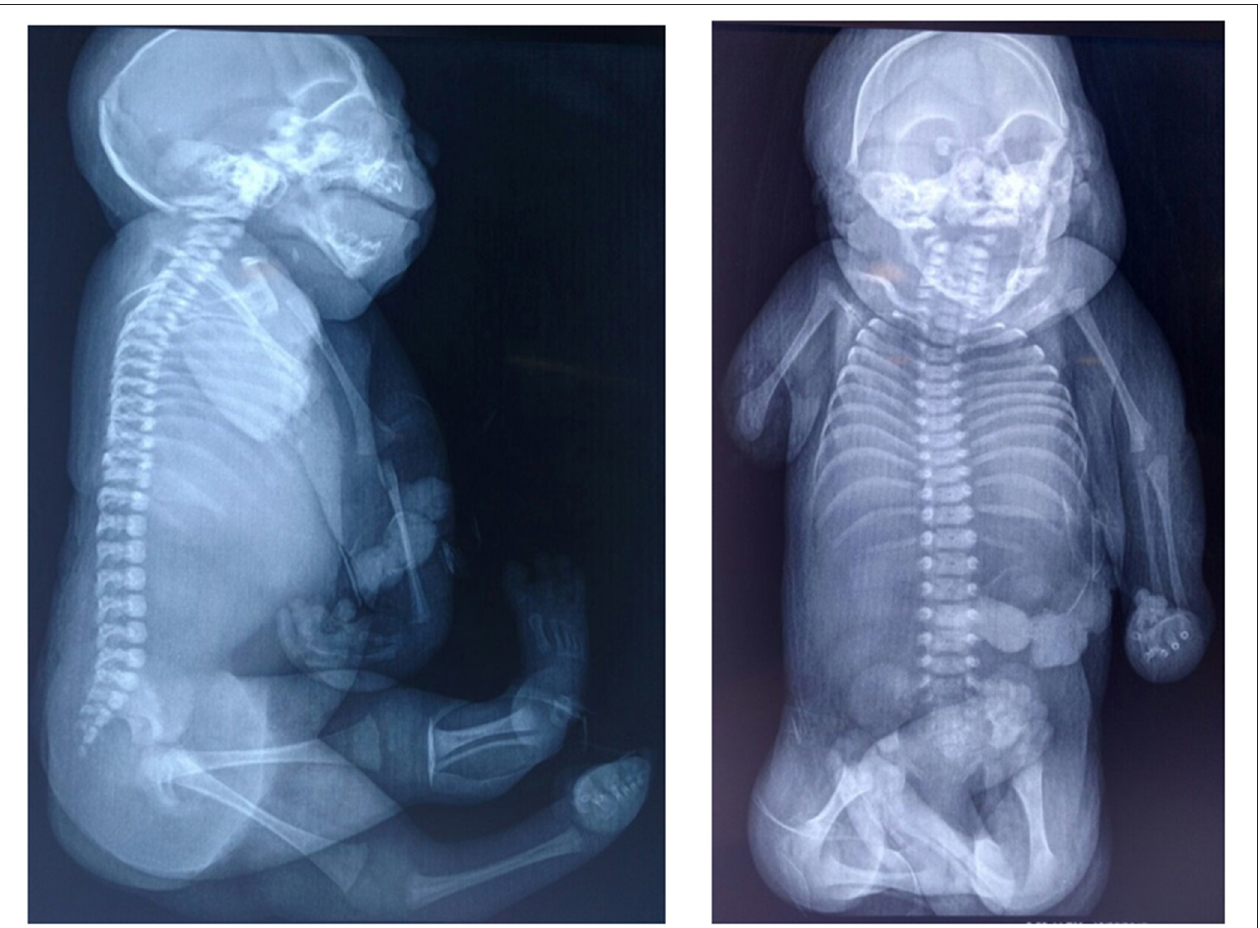
FIGURE 2 | X-ray imaging. In both image it appreciate skull with everted sutures and partial collapse of the cranial bones. Asymmetry is observed in the length of the right and left